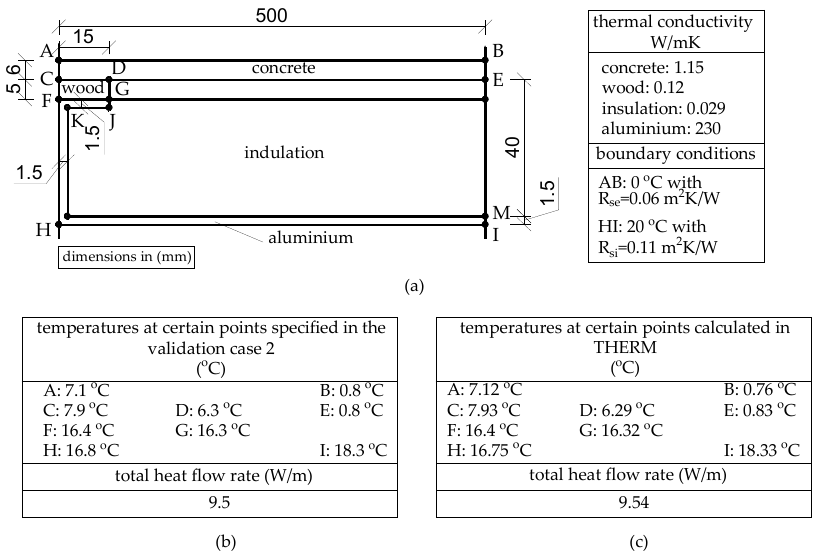
Figure 11. ( a ) Geometry and boundary conditions for test case 2 of Annex C PN-EN ISO 10211:2011, ( b ) Analytical solution at grid nodes for test case 2 of Annex C PN-EN ISO 10211:2011, ( c ) Calculation results in THERM at analyzed grid nodes.